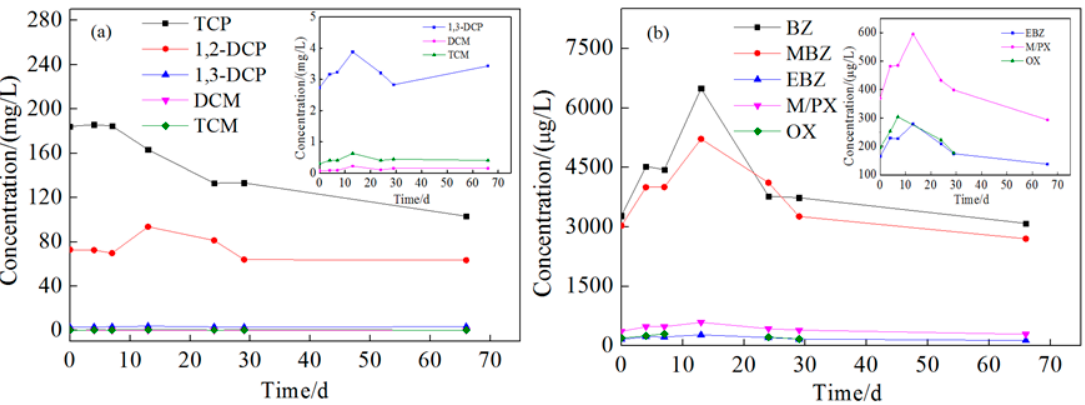
Figure 11. Concentration changes of pollutants at the shallow monitoring well 2 m downstream. Ordinate: ( a ) The concentration of chlorinated hydrocarbons; ( b ) the concentration of BTEX. Inset: ( a ) Amplified concentration change curves of 1,3-DCP, DCM, and TCM; ( b ) amplified concentration change curves of EBZ, M/PX, and OX.